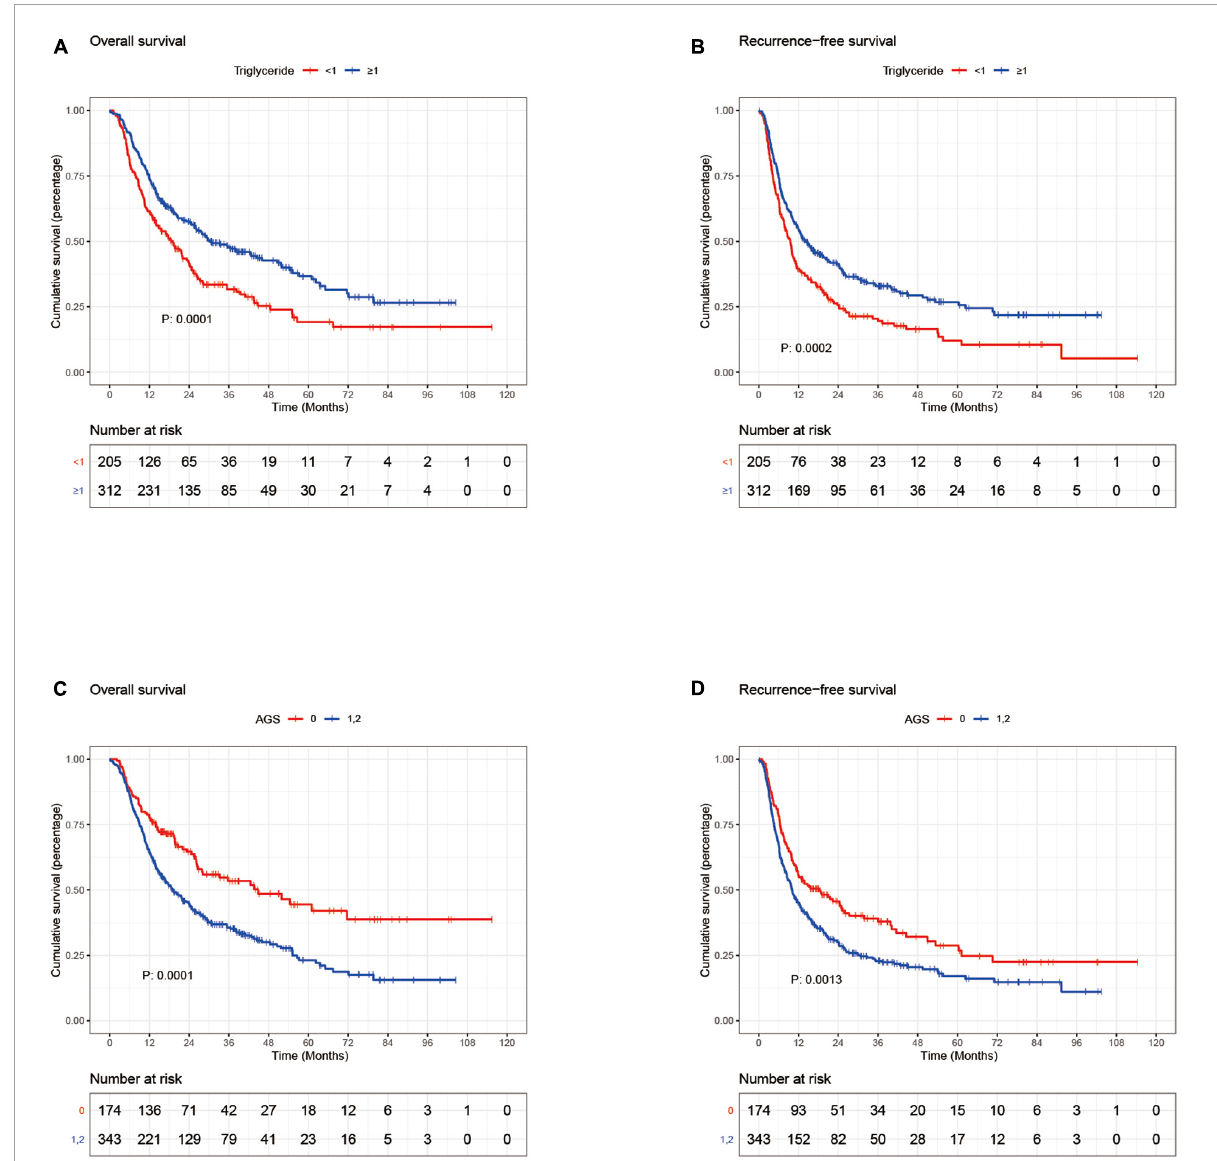
FIGURE1 Kaplan–Meier curves for overall survival and recurrence-free survival stratified by triglyceride (A,B) and AGS (C,D) in the discovery set; AGS, albumin-globulin